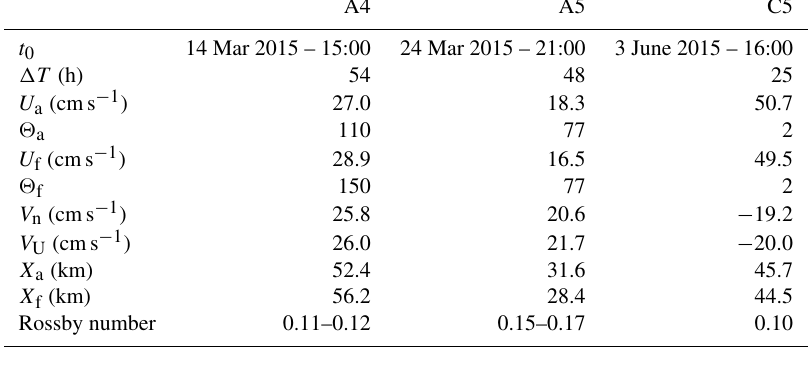
Table 4. Estimate eddy parameters. t 0 : the eddy’s center apparent at M4; (cid:49)T : temporal half eddy duration; U/(cid:50) a / f ( X a / f ) : the estimated mean flow magnitude and direction (eddy apparent radius) using the angle method (subscript “a”) or the filtering method (subscript “f”). V n /V U : the estimated maximum eddy currents using the normal (subscript “n”) or the U subtraction method (subscript “U”). Rossby number using the different value for V and X .